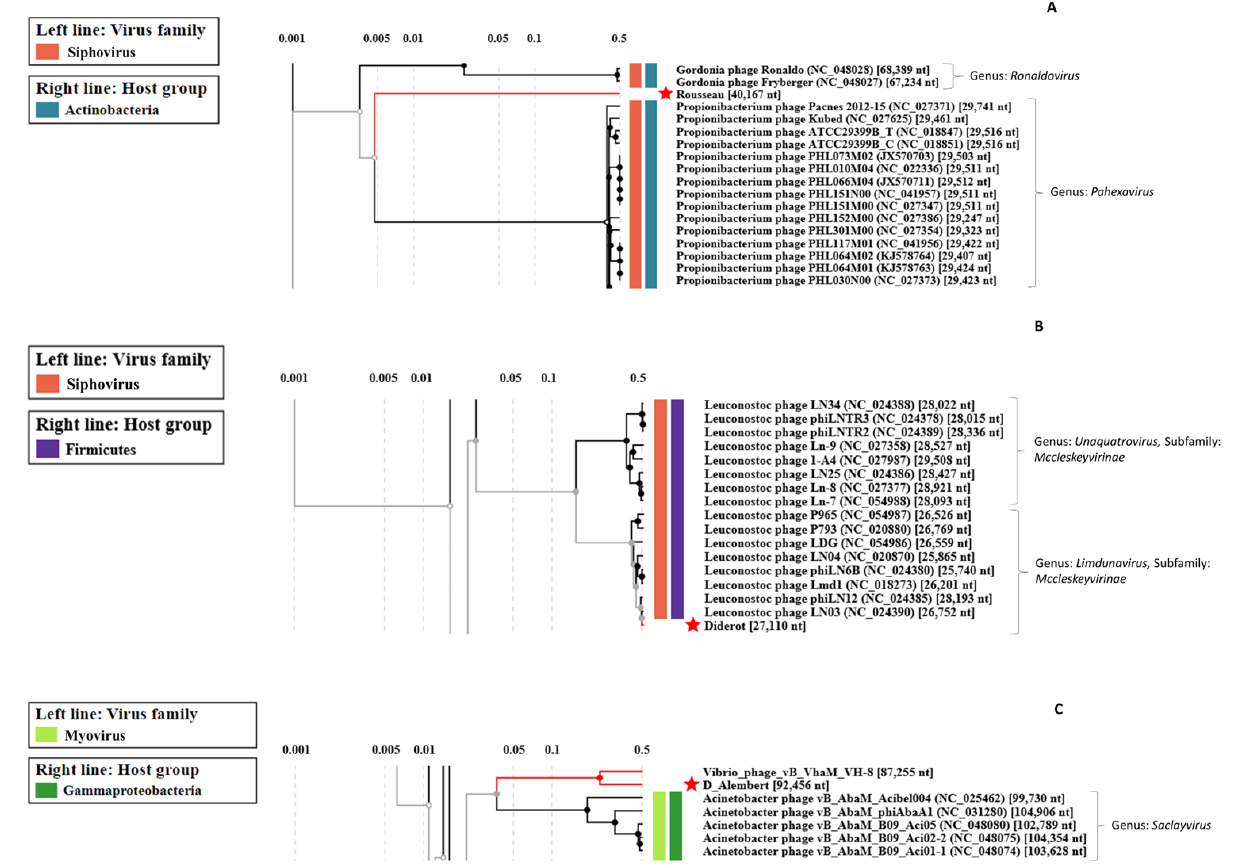
Figure 3. Screenshots of proteomic trees of ( A ) Rousseau, ( B ) Diderot, ( C ) D’Alembert and related phages, computed with ViPTree. Red stars indicate the position of the newly sequenced phage genomes. Brevibacterium phage Rousseau has 71 ORFs of which 41 have functional